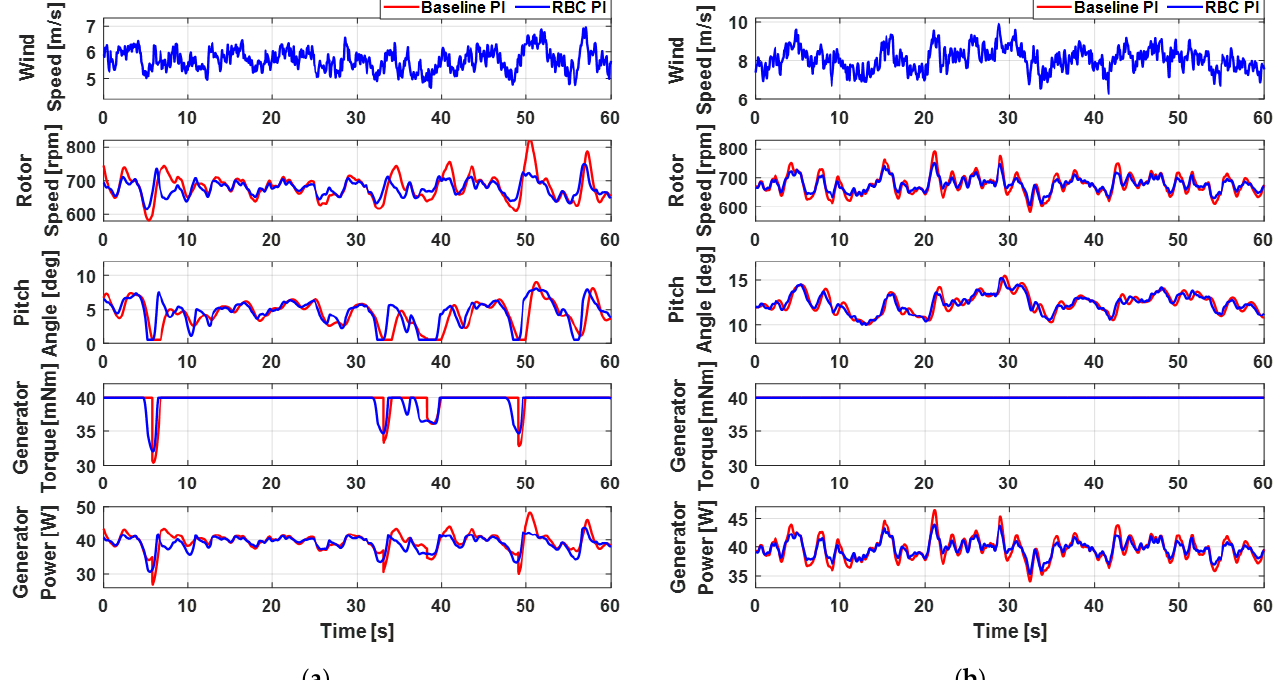
Figure 10. Results from HILS testing of scaled wind turbine model: ( a ) average wind speed of 6 m/s and 10% turbulence intensity; ( b ) average wind speed of 8 m/s and 10% turbulence intensity.